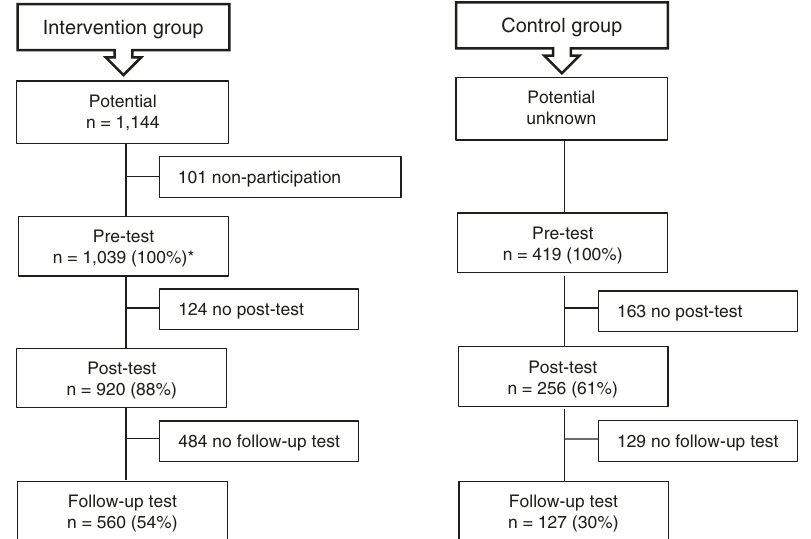
Fig. 1 Flowchart of the number of participants in the intervention group and control group. Participants are PhD students in the intervention group and Master students in the control group. *The total number of participants in the intervention group is 1044. Five participants did not fi ll out the pre-test.